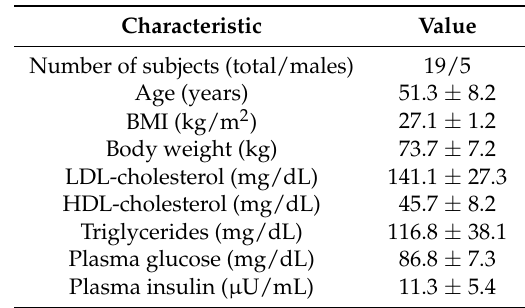
Table 2. General characteristics of the study population (mean ± SD).